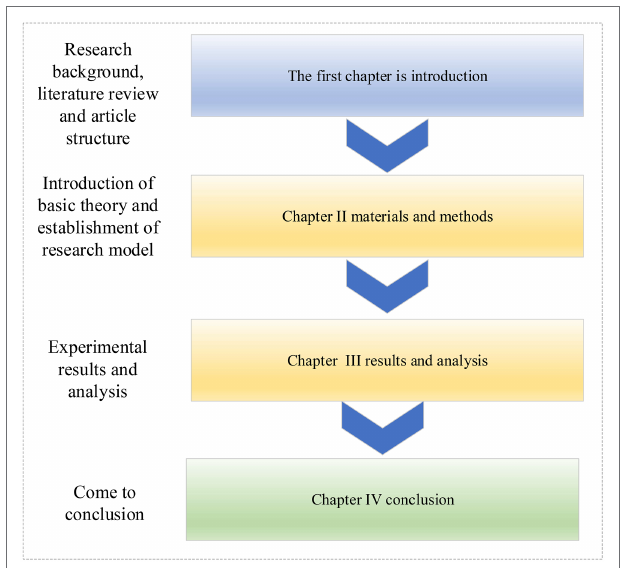
FIGURE 1 | Article organization structure.